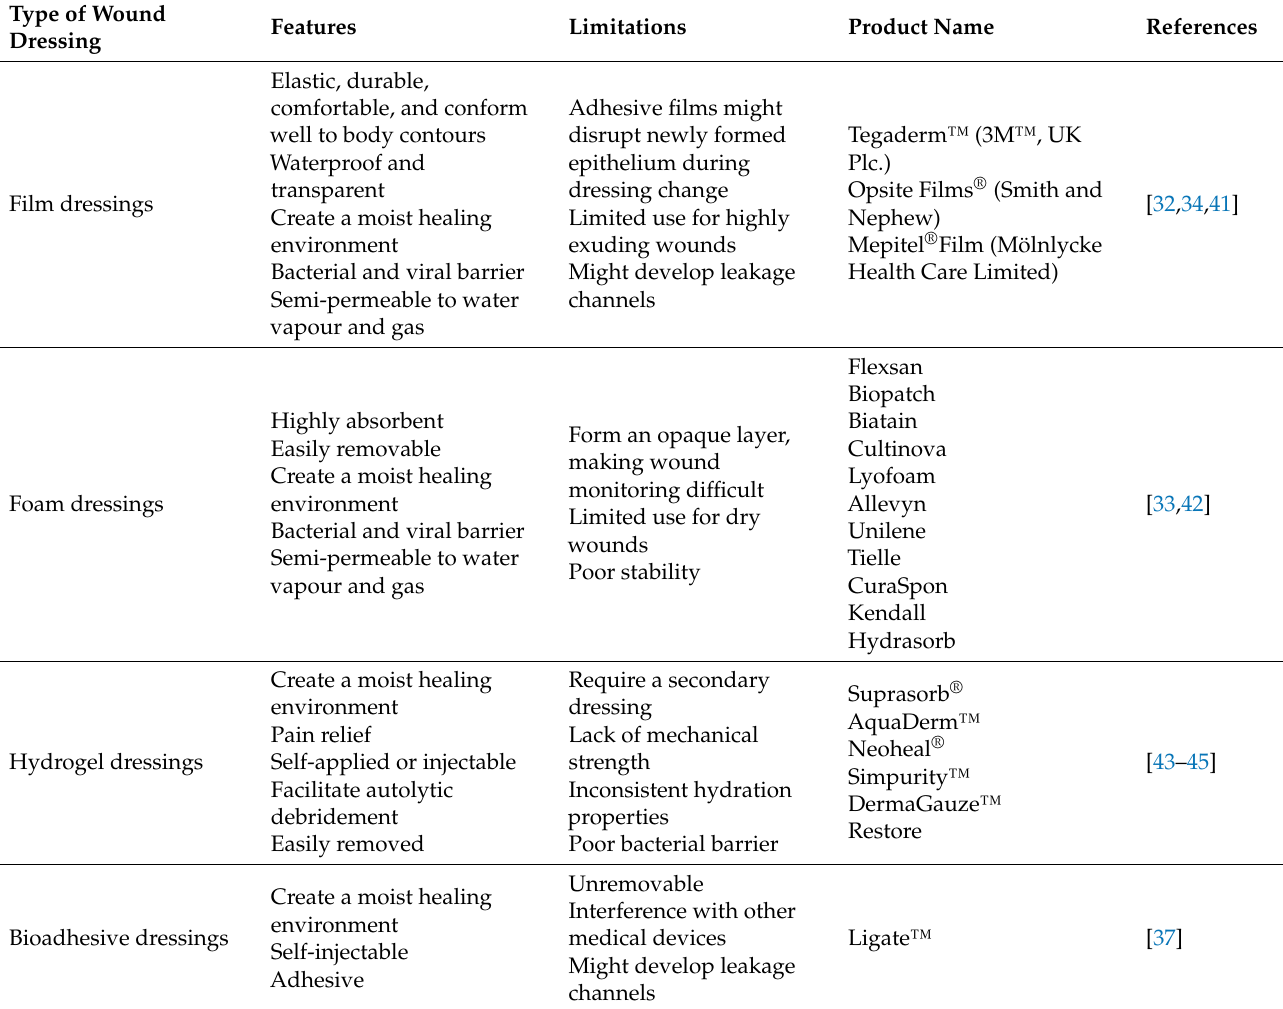
Table 1. Characteristics of wound